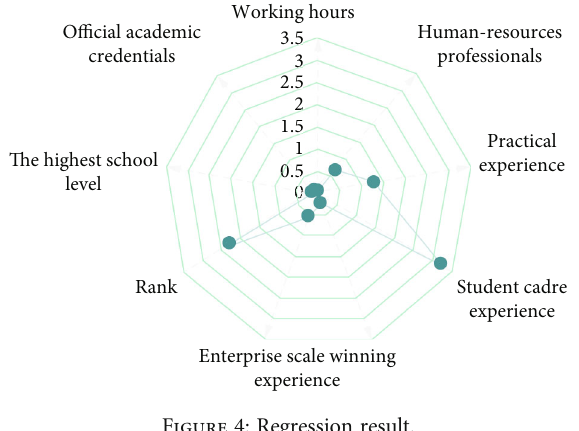
Figure 4: Regression result.